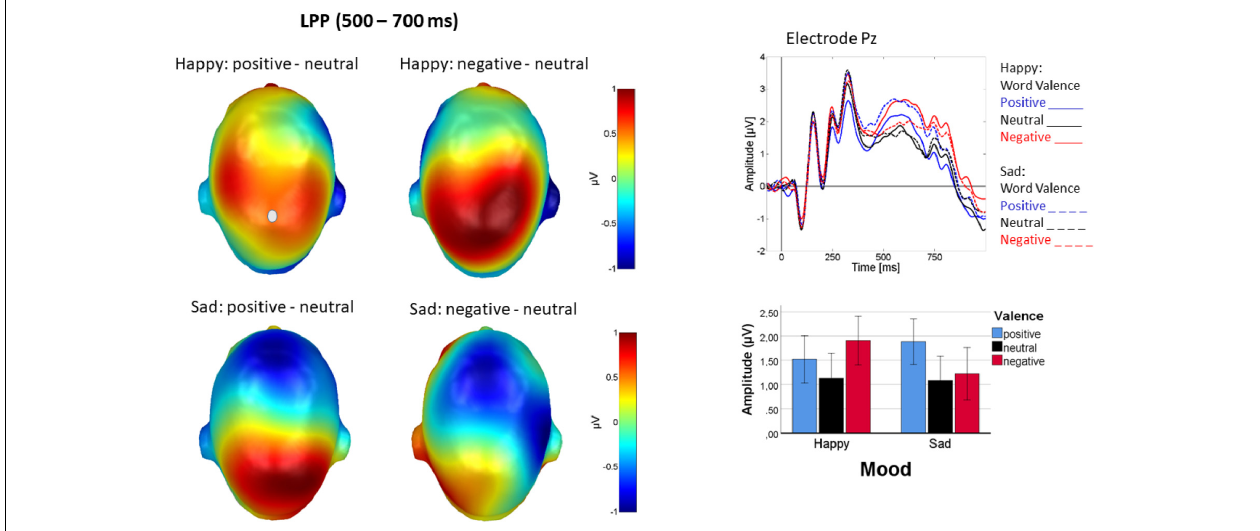
FIGURE 7 | LPP difference topographies depicting word processing in happy mood (left panel, top row) and sad mood (left panel, bottom row) . Top of right panel shows ERPs at sensor Pz, where solid lines represent happy mood and dashed lined sad mood. Blue is positive, red negative, and black neutral word valence. A bar chart (bottom right) depicting mean activity from the centro-parietal sensor group across the LPP time interval (500–700 ms) illustrates the interaction. Particularly mood-incongruent words elicited higher LPP amplitudes. Error bars are standard